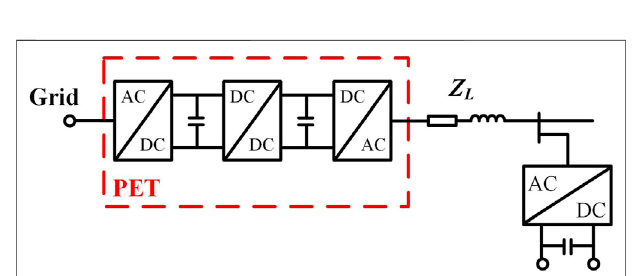
FIGURE 4 | System con fi